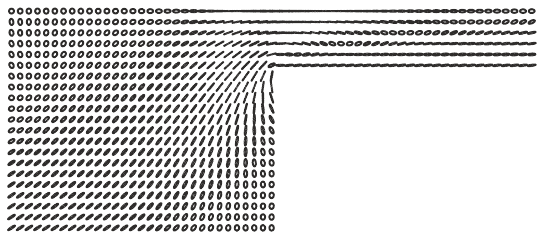
Figure 6: The backbone orientation distribution.